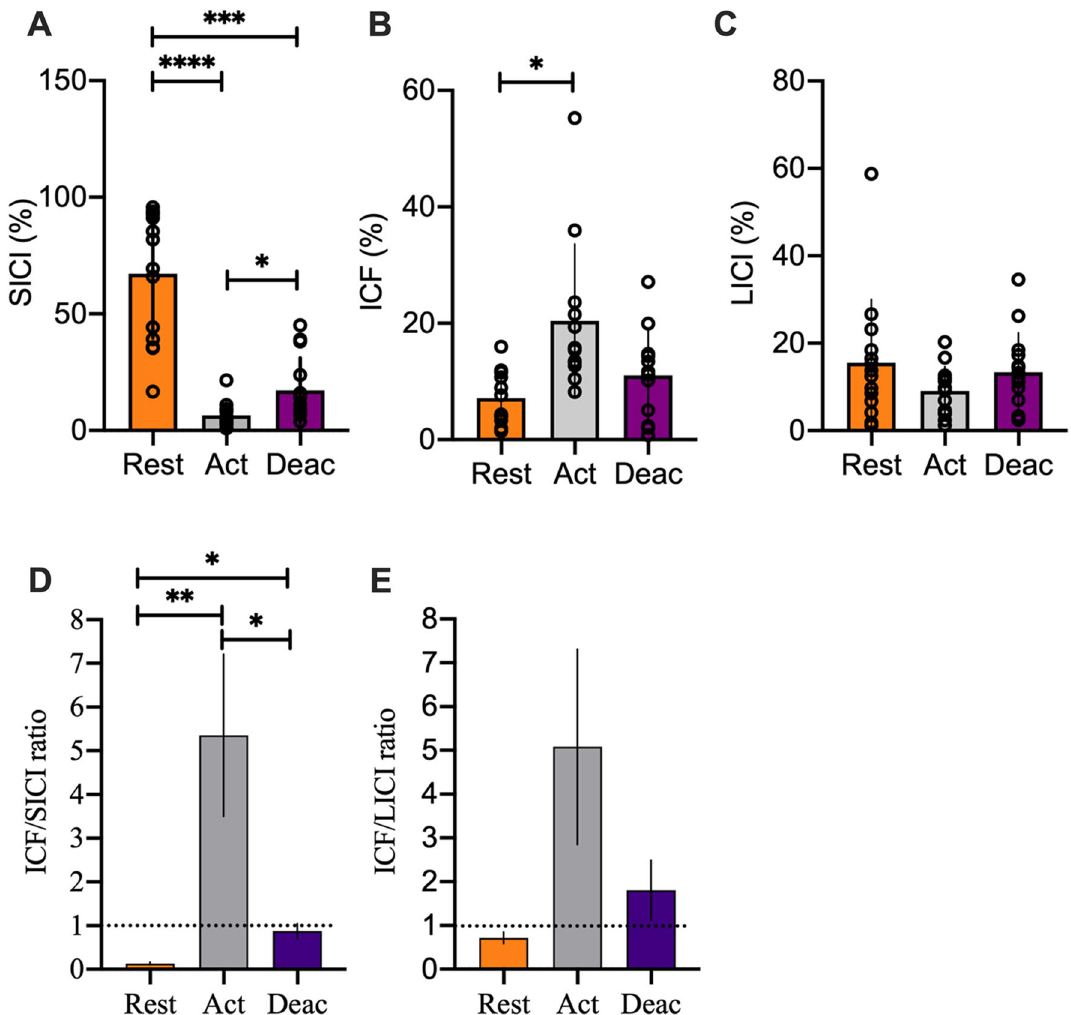
Figure 3. Overview of the group mean TMS responses. The figure shows the group means during rest (orange), activation (grey) and deactivation (purple) for SICI ( A ), ICF ( B ) and LICI ( C ). Panels ( D ) + ( E ) show the ICF to SICI and the ICF to LICI ratio, respectively (****p ≤ 0.0001, ***p ≤ 0.001, **p ≤ 0.01, *p ≤